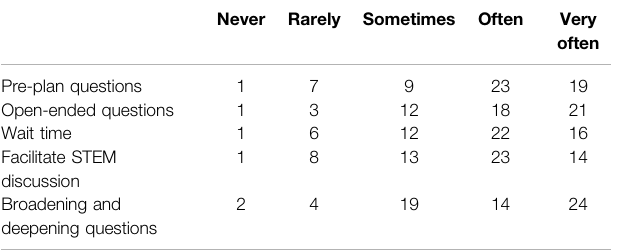
TABLE 4 | ACRES pedagogy and strategy implementation, by purposeful questions